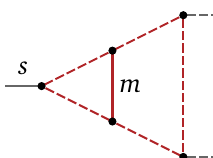
Figure 2: Two-loop triangle with one internal massive